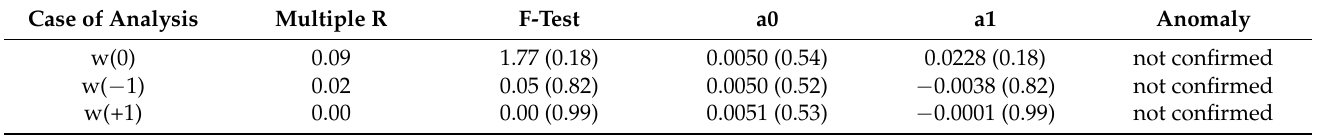
Table A12. Regression analysis with dummy variables: results of the expiration price effects